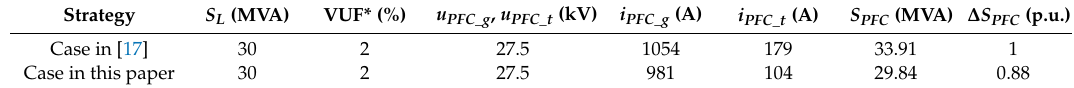
Figure 19. Simulation results of the power flow controller (PFC) working process with unbalanced compensation .